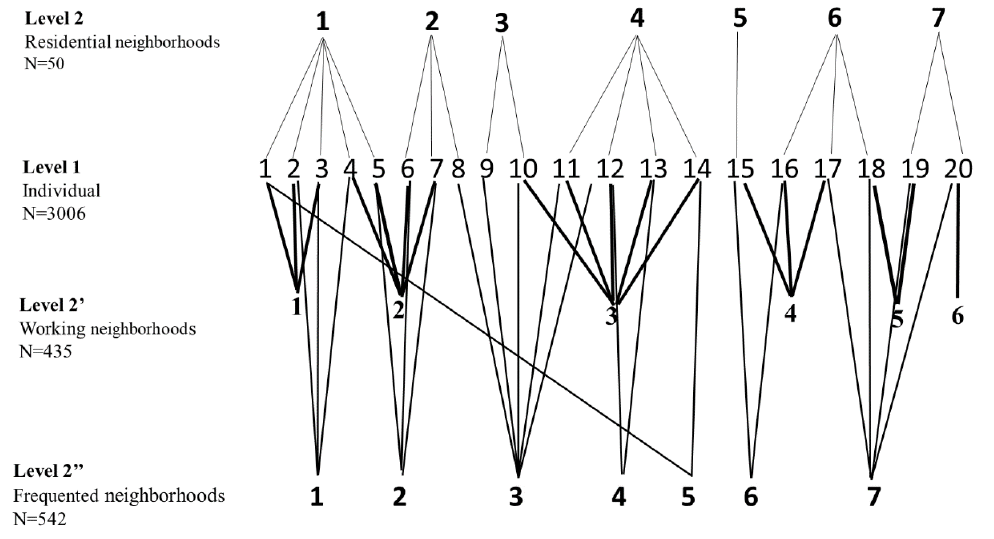
Figure 1. Cross-classified multilevel logistic models.